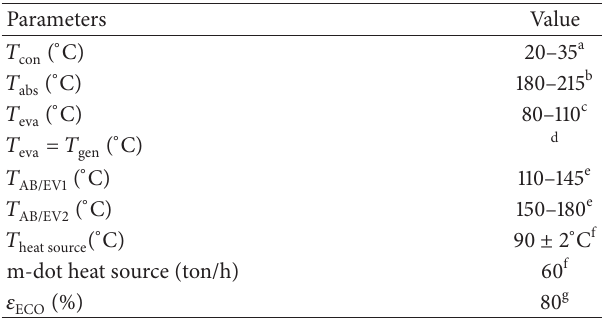
Table 2: The input data of